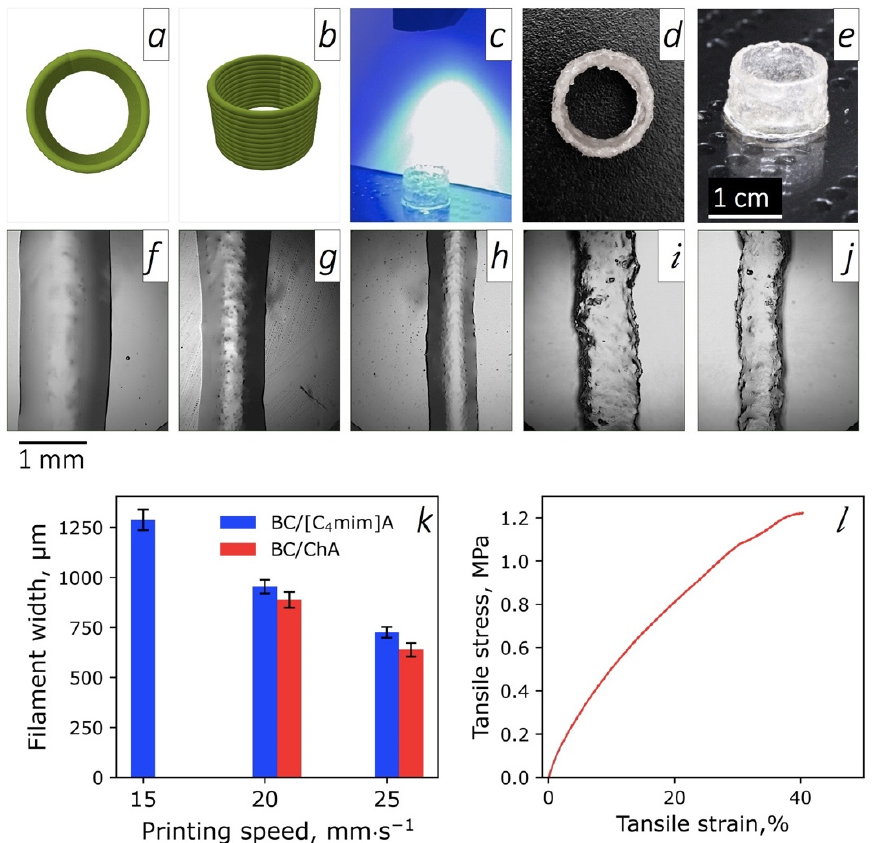
Figure 8. The CAD model of the hollow cylinder ( a , b ); photos of the photocuring process at 3D printing ( c ); and the resulting cylinder in various views ( d , e ). The optical micrographs of 3D printed filaments (magnification of ×10) for BC/[C 4 mim] А ink ( f – h ); at the printing pressure of 50 kPa and BC/ChA ink ( i , j ); at the pressure of 250 kPa at varied nozzle moving speeds of 15 ( f ), 20 ( g , i ), and 25 mm ∙ s –1 ( h , j ). The dependences of filament width on the printing speed ( k ). Typical stress-strain curve for the UV-cured BC/ChA sample ( l ).